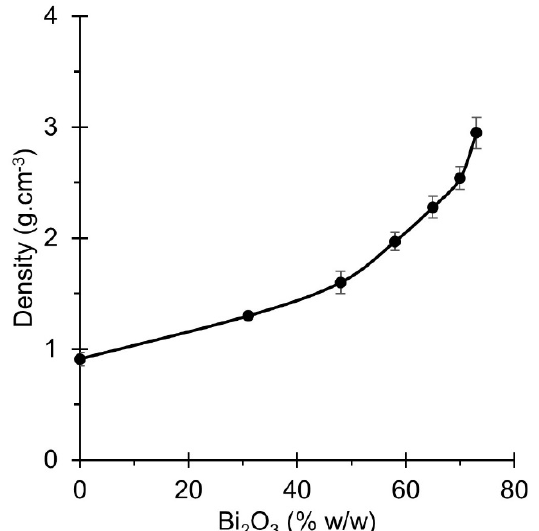
Figure 6. Density of the GNRL/micro-Bi 2 O 3 films at different loadings of micro-Bi 2 O 3 . Results are expressed as means ( n = 10) ± 1 s.d. Table 3. Prepared GNRL/Bi 2 O 3 films by casting with different weight fractions (wt %) of attenuating filler and GNRL, amount of suspension added to the Petri dishes, and film thickness.